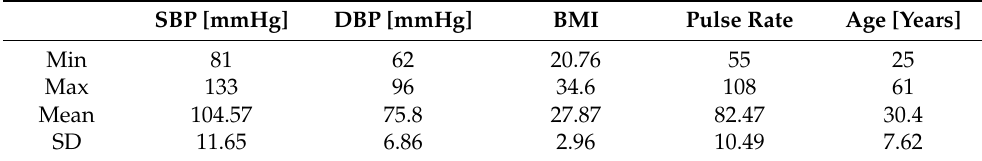
Table 8. Statistical information from the subjects (No. of subjects =